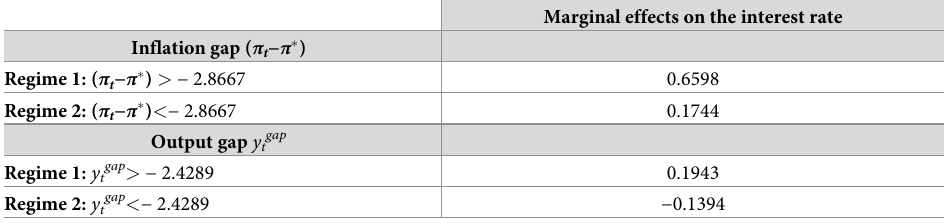
Table 4. Marginal effects of the two regimes defined by the estimated threshold